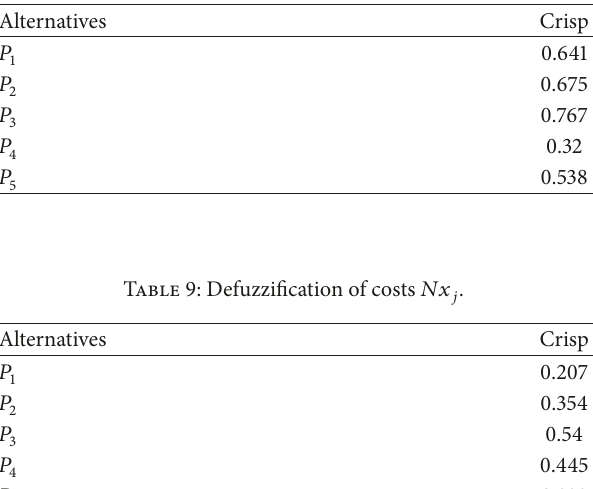
Table 3: The importance of DM.